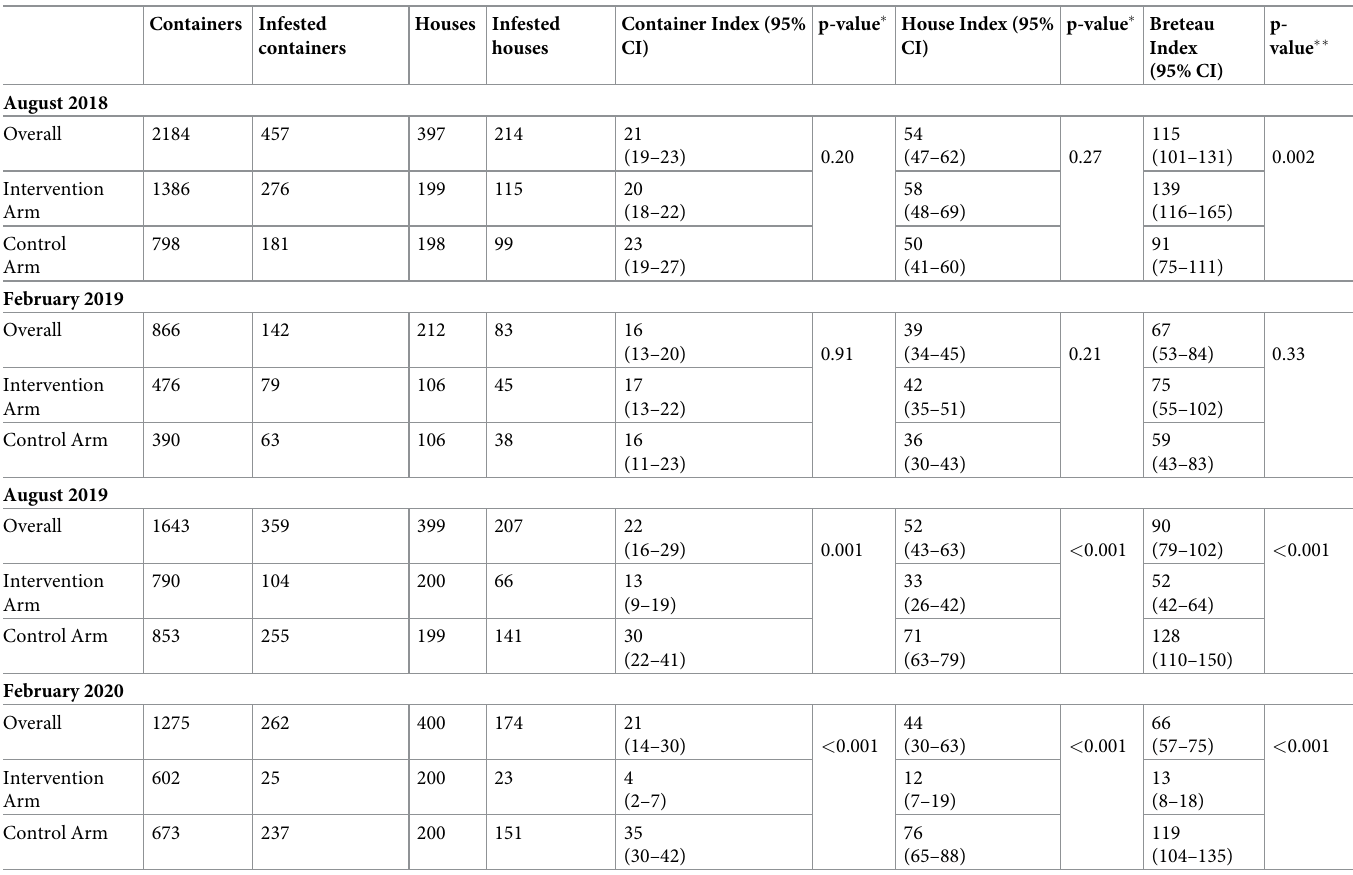
Table 2. Container Index, House Index and Breteau Index by survey time